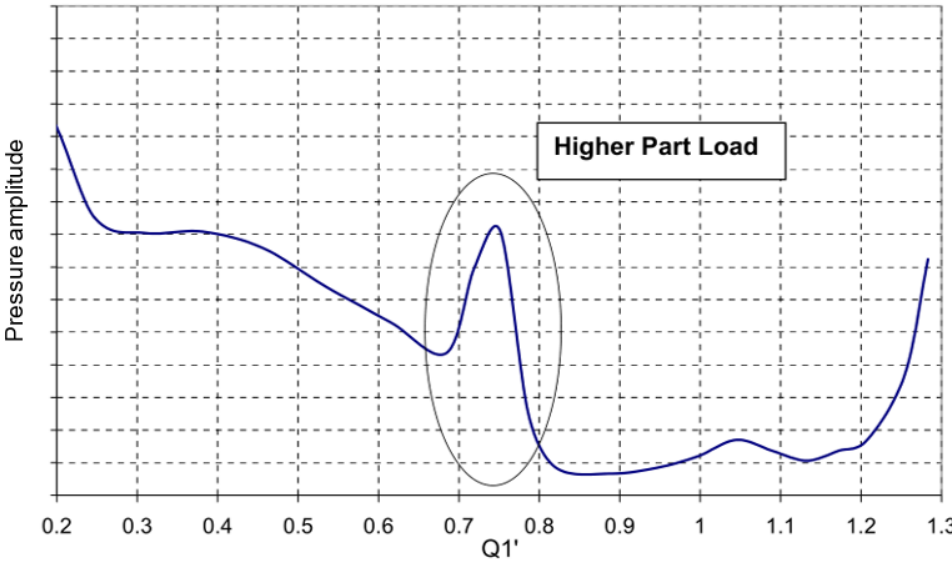
Figure 6. Typical pressure trend in a model Francis turbine draft tube cone